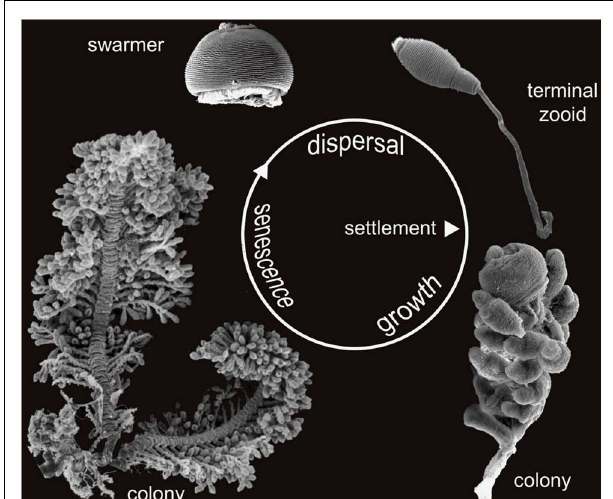
FIGURE 3 | Life cycle of Zoothamnium niveum . Scanning electron microscopy of the different stages of development.The dispersive stage, the swarmer, is released from the colony and settles to grow a new colony. The new colony initially consists of a single cell, the terminal zooid, which divides to grow a whole colony. After a growing phase the adult colony enter a senescence stage. Not in scale.